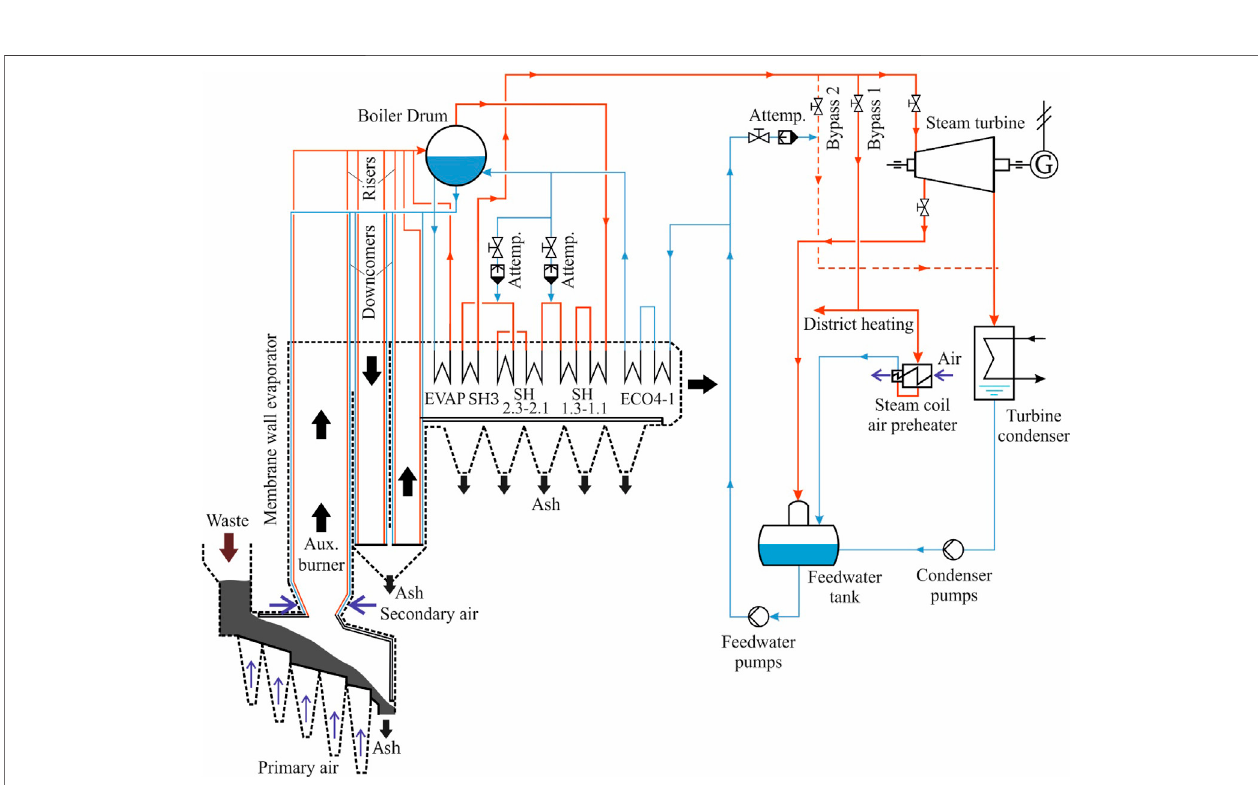
Frontiers in Energy Research |